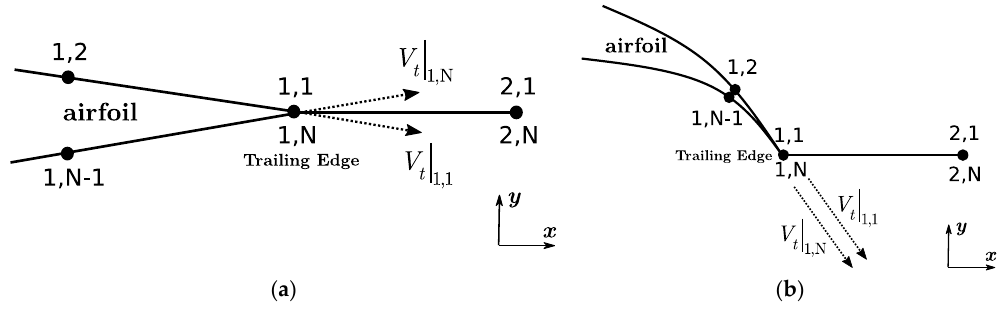
Figure 5. Grid notation and tangential velocity components at trailing edge. ( a ) Finite angle trailing edge. ( b ) Cusped trailing edge.